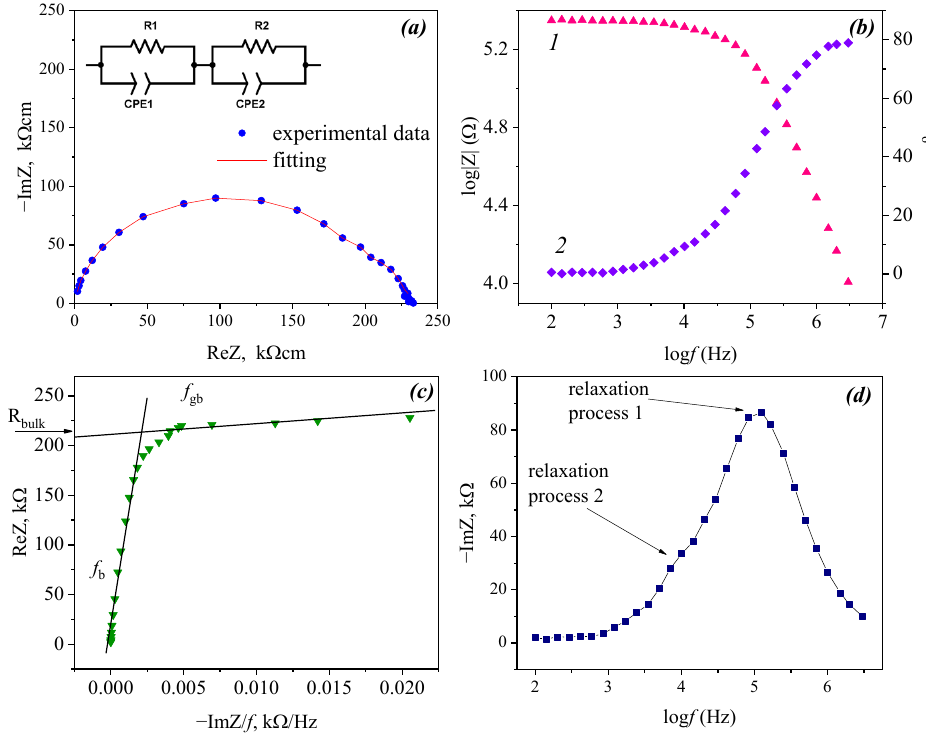
Figure 8. The example of the impedance data fitting for Ba 5 In 2 Al 2 ZrO 13 and corresponding equivalent circuit, R1, R2, CPE1 and CPE2 represent the bulk resistance, grain-boundary resistance, constant phase element of the bulk and constant phase element of the grain-boundaries (wet air p H 2 O = 1.92 · 10 − 2 atm, 464 ◦ C) ( a ); the impedance data shown in the coordinates of the logarithm of the impedance magnitude (1) and phase-shift (2) vs. the logarithm of the frequency ( b ). The impedance spectrum shown in the real part of impedance ReZ vs. ImZ/ f representation ( c ). Impedance data shown as imaginary part ImZ vs. the logarithm of the frequency ( d ).